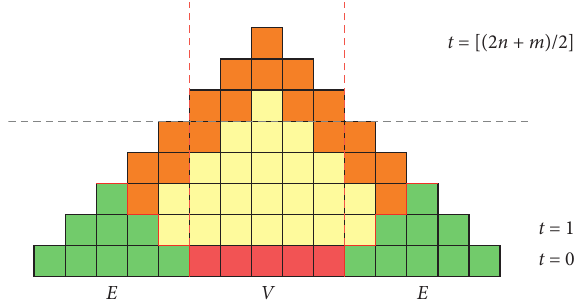
Figure 1: Diagram displaying an example of the inverted light cone IL ( C ) of the input set of cells C . The input includes volume V (in red) and environment E (in light green). The output O (in orange) contains the cells within the future light cone of C that are in the Moore neighborhood of a cell outside of IL ( C ) . The combination of yellow and orange cells denotes the future light cone of volume V within IL ( C ) . The red line shows the border between the envi- ronment's inverted light cone and the future lightcone of the volume. The vertical dashed lines show the future of the volume, and the horizontal dashed line shows the limit of computation considered at some time t , in Janzing’s approach